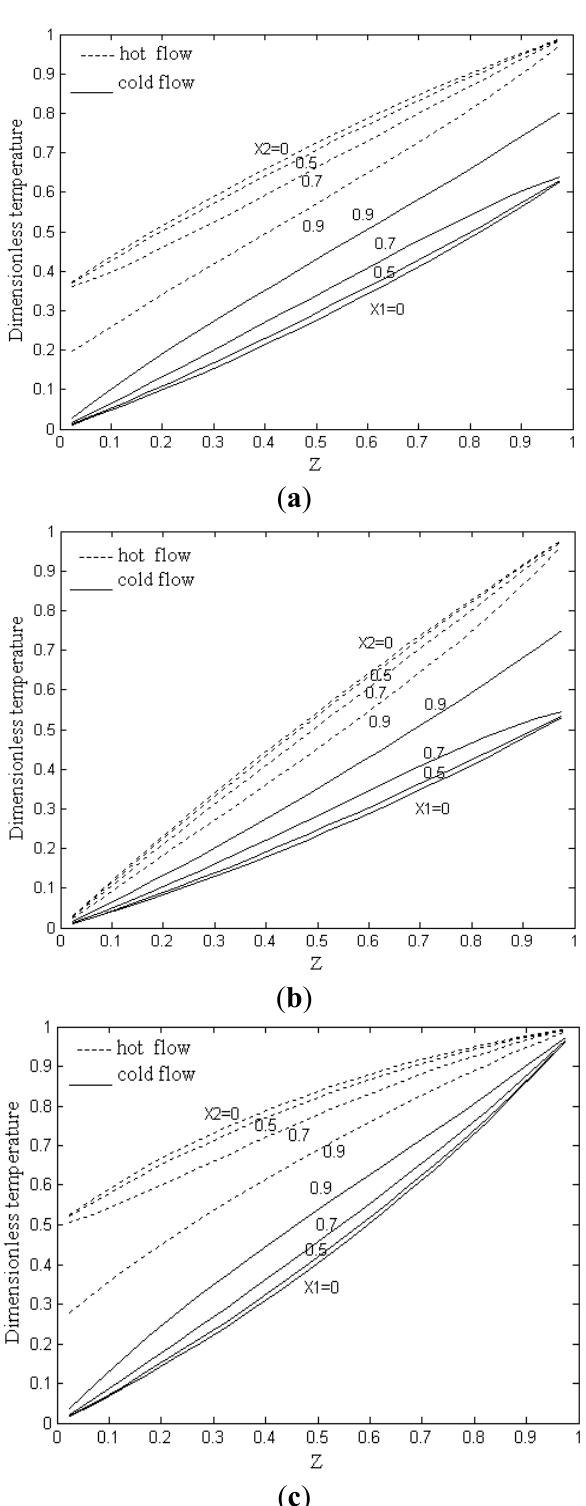
Figure 4. Temperature distribution for a counter flow plate heat exchanger (Plug flow). ( a ) Two dimensional temperature distribution for K = 1, H = 0.5, K W = 0; ( b ) Two dimensional temperature distribution for K = 1, H = 1, K W = 0; ( c ) Two dimensional temperature distribution for K = 1, H = 2, K W =